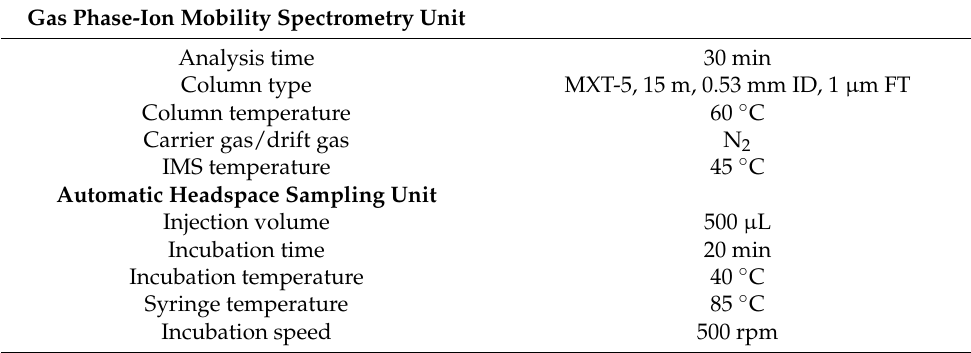
Table 1. Analysis conditions for cherry fruits and their wines by